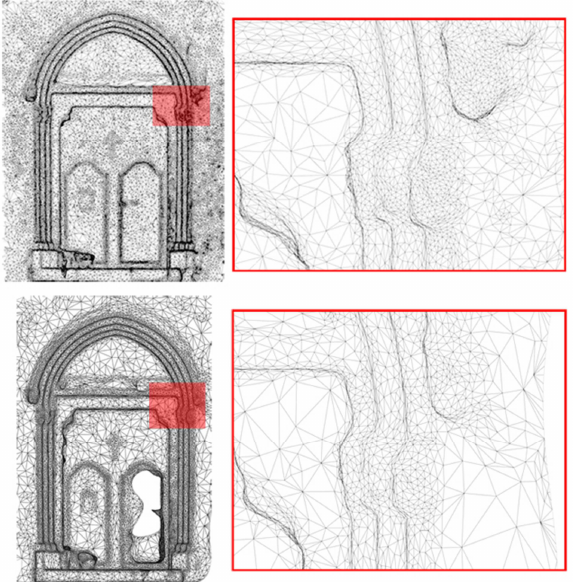
Figure 5. Comparison of the mesh obtained with two different cameras: a) model1, Canon EOS 350D; b) model2, Casio EX- H15